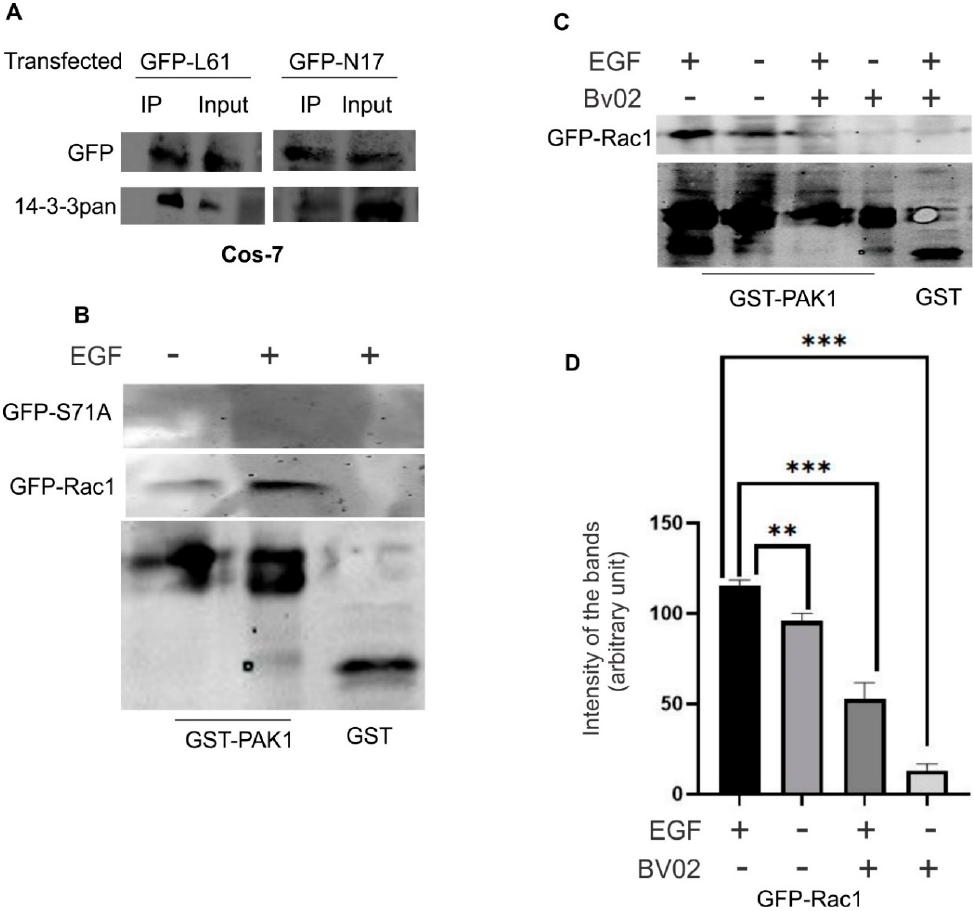
Figure 3. The relationship between Rac1 activity and its interaction with 14-3-3s in Cos-7 cells. ( A ) The effects of Rac1 activity on the interaction between 14-3-3s and Rac1. Cos-7 cells were transfected with either constitutively activated Rac1 (GFP-L61) or dominant-negative Rac1 (GFP-N17). The interaction of these two mutants with 14-3-3s was examined by co-IP as described above. ( B ) The effects of Rac1 S71 mutation to A on the activation of Rac1. Cos-7 cells were transfected with either GFP-Rac1 or mutant GFP-S71A, incubated with or without EGF for 15 min, and lysed. The cell lysates were incubated with GST fusion Rac-binding domain of PAK (GST-PAK) or GST bound to glutathione-agarose beads. The active Rac1 that binds to GST-PAK was determined by immunoblotting with an antibody to GFP; GST-PAK and GST were detected with an antibody to GST. ( C ) The effects of BV02 on the activation of Rac1. Cos-7 cells were transfected with GFP-Rac1 and incubated with BV02 at a concentration of 30 μ M for 24 h. The cells were then incubated with or without EGF for 15 min. Cells were then lysed and the cell lysates were incubated with GST-PAK or GST bound to glutathione-agarose beads. The active Rac1 that binds to GST-PAK was determined by immunoblotting with an antibody to GFP; GST-PAK and GST were detected with an antibody to GST. ( D ) Quantification of the data in ( C ). The pulled-down active Rac1 bands were quantitated by densitometry. Each value is the average of at least three experiments and the error bar is standard error. ** p < 0.01, *** p < 0.001.